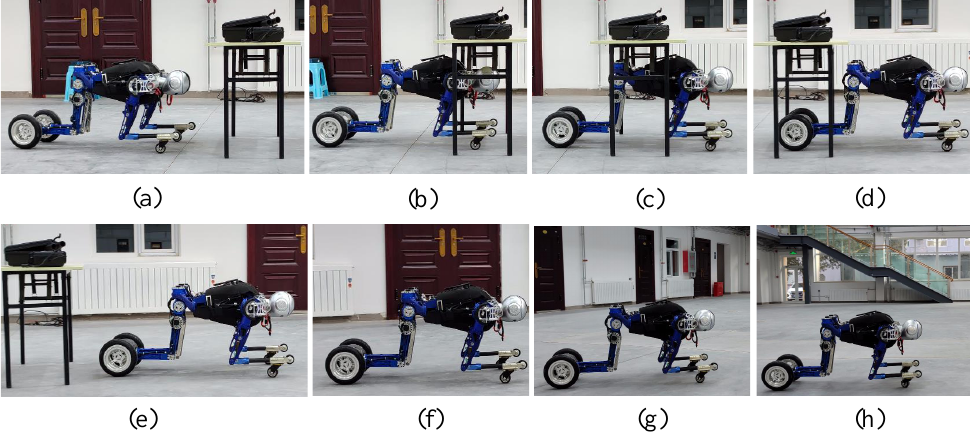
Figure 13. The robot crosses a channel with a size of 30 cm × 80 cm × 60 cm and performs a turn ( a – h ).